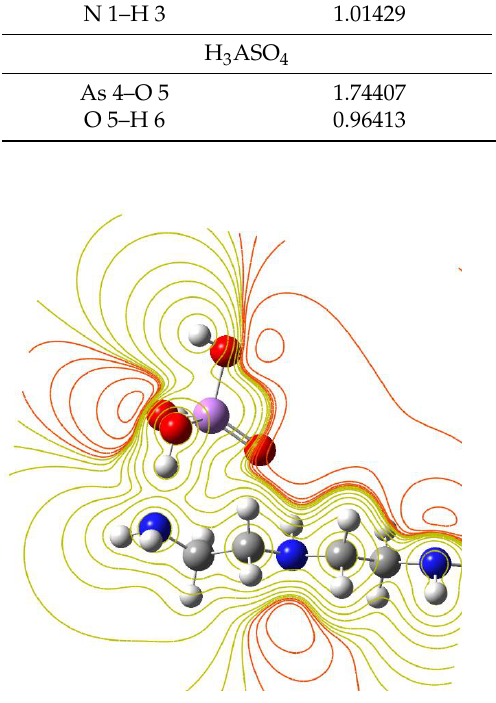
Figure 11. Contour mapping of As-TEPA-GTS.